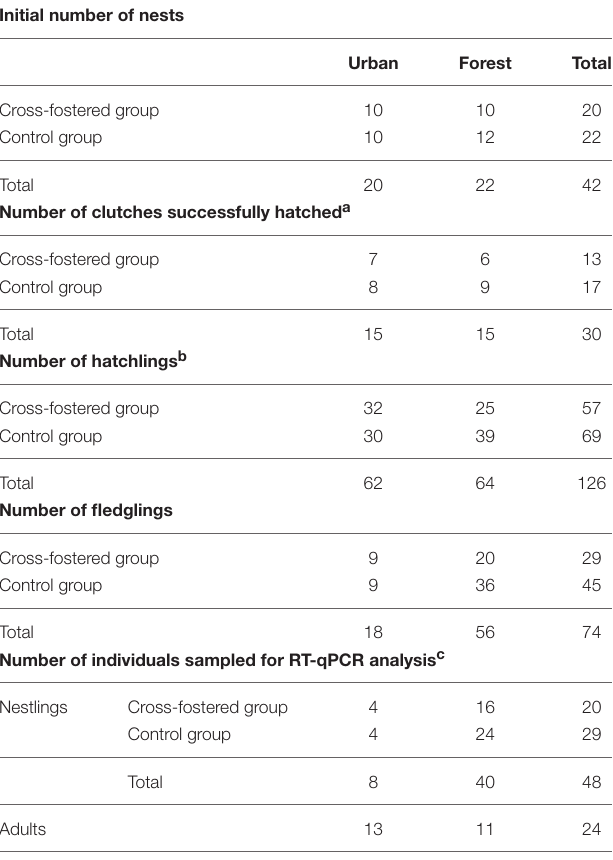
TABLE 1 | Summary of sample sizes that entered the analysis: number of clutches, nestlings and adults of each experimental group at every breeding stage for our two study